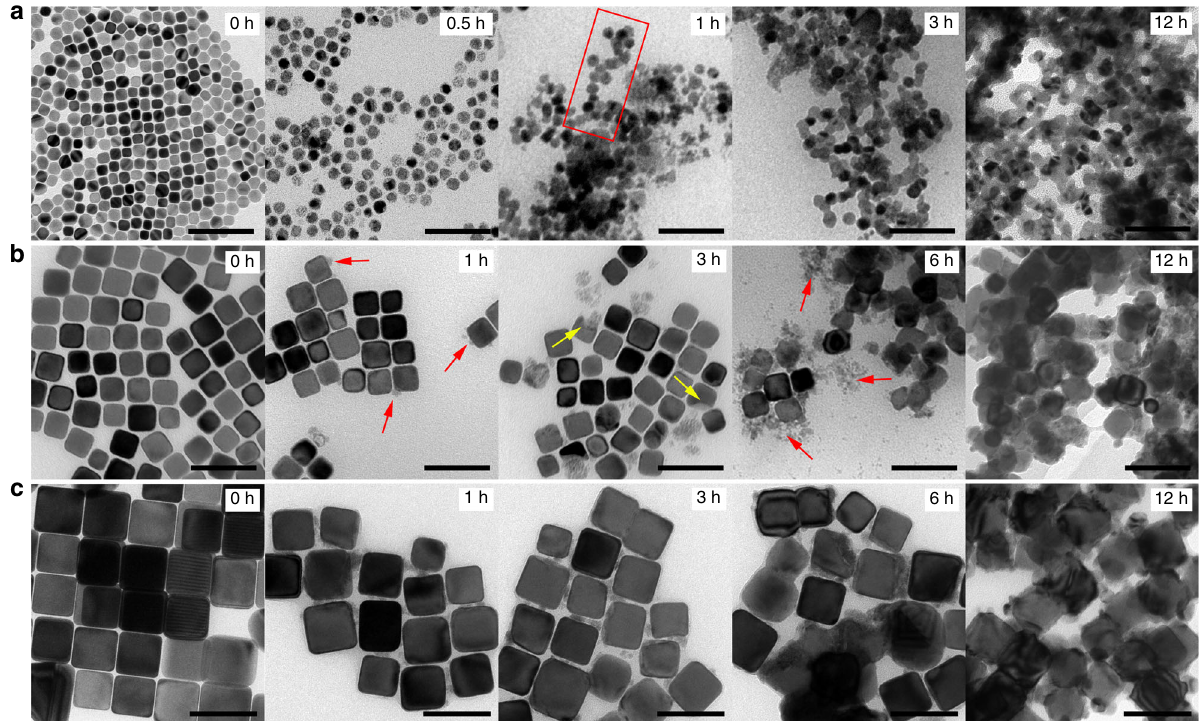
Fig. 1 Morphological evolution of the CuNCs during electrolysis. a – c Representative CuNCs of three different sizes: a 16 nm, b 41 nm, and c 65 nm, imaged with TEM at different operation times. The rectangle in a encloses an aggregated assembly of particles. The red and yellow arrows in b indicate small clusters and broken CuNCs, respectively. Scale bars: 100